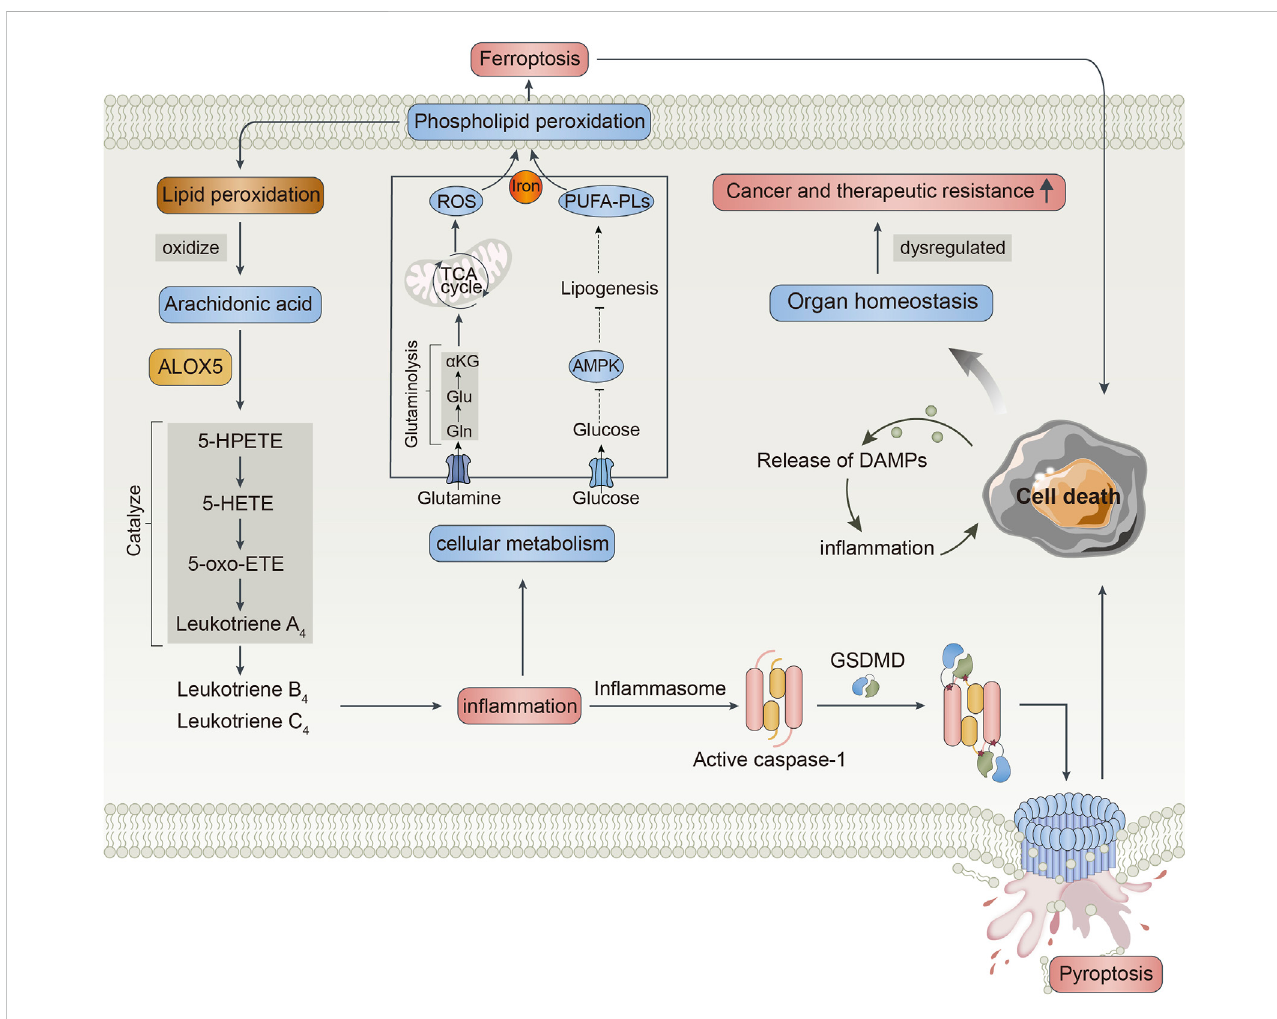
FIGURE 13 The possible mechanism of ALOX5 involvement in low-grade